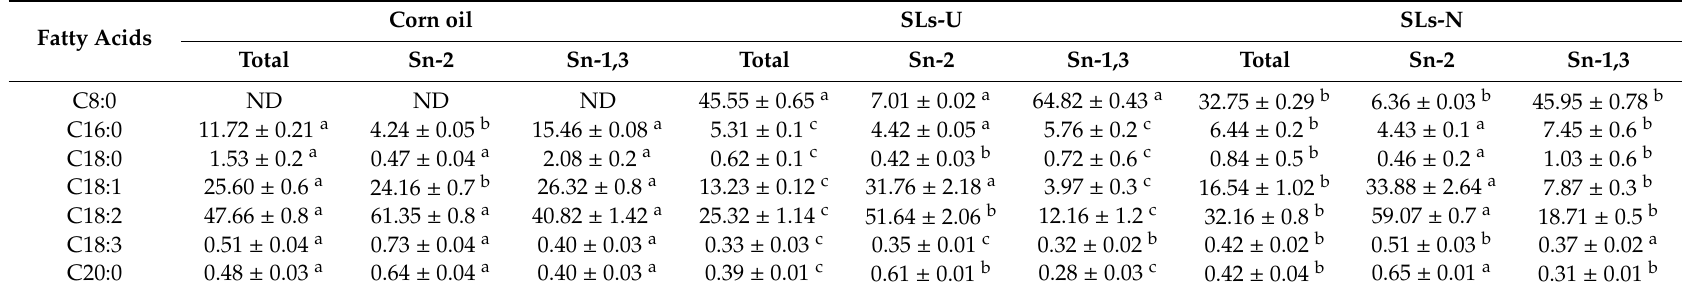
Table 1. Fatty acids composition (%) and positional distributions of corn oil, SLs-U, and